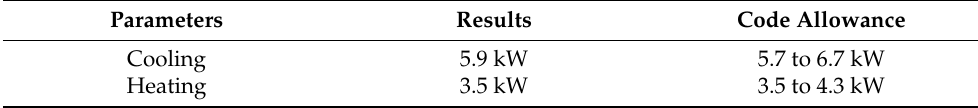
Table 8. ASHARE 140 test